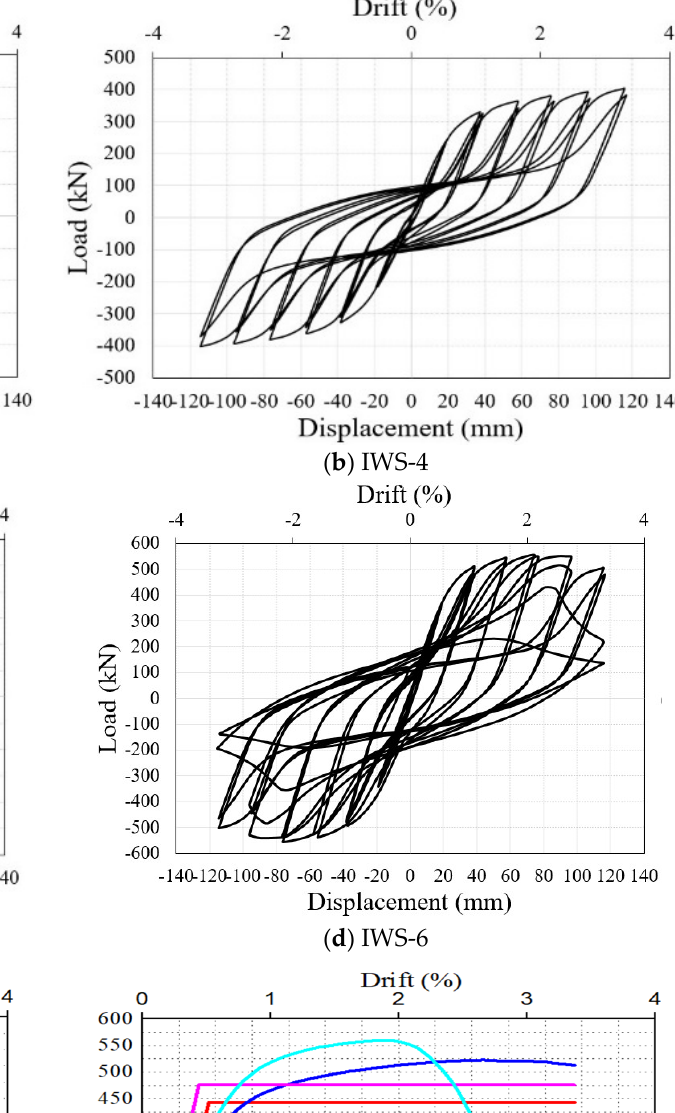
Figure 18 . Parametric FE models: Effect of the steel yield stress and infill-strip thickness.